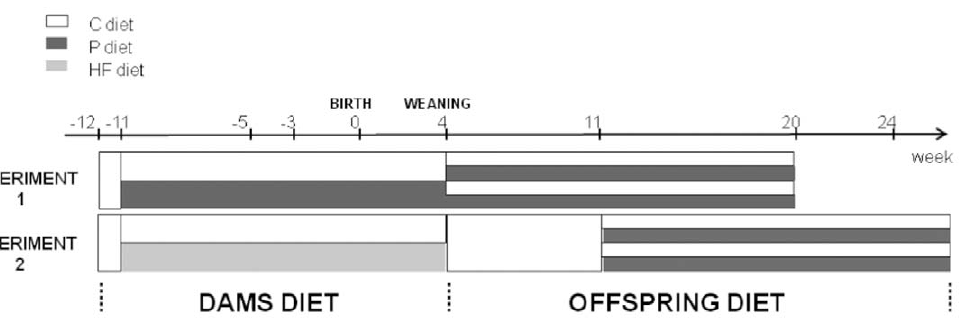
Figure 1. Model depecting the experimental protocol for experiment 1 and experiment 2. C, P and HF diets correspond to Chow, High palatable diet and High Fat diet, respectively.